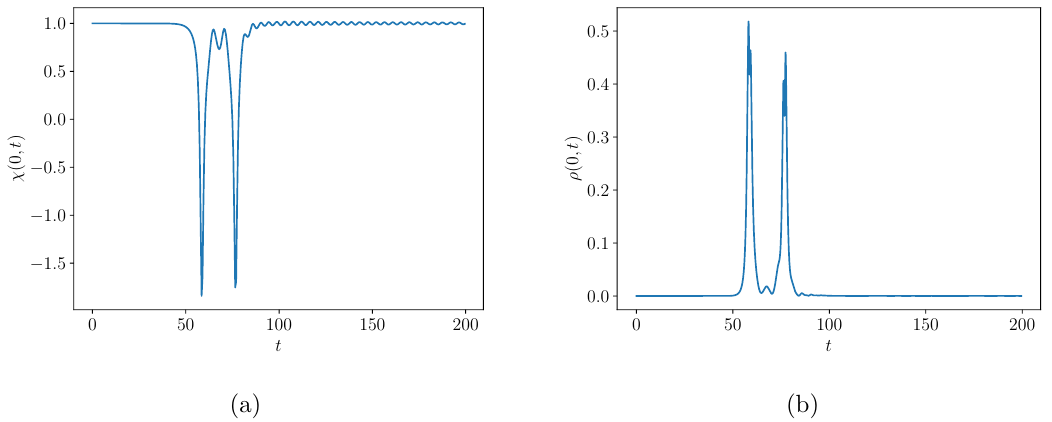
Figure 8 . Evolution of (a) scalar field and (b) the fermion density at the center of the collision. We consider the attractive case where the fermions start at the zero mode. Parameters are v i = 0 . 235 and φ 0 = 0 . 8